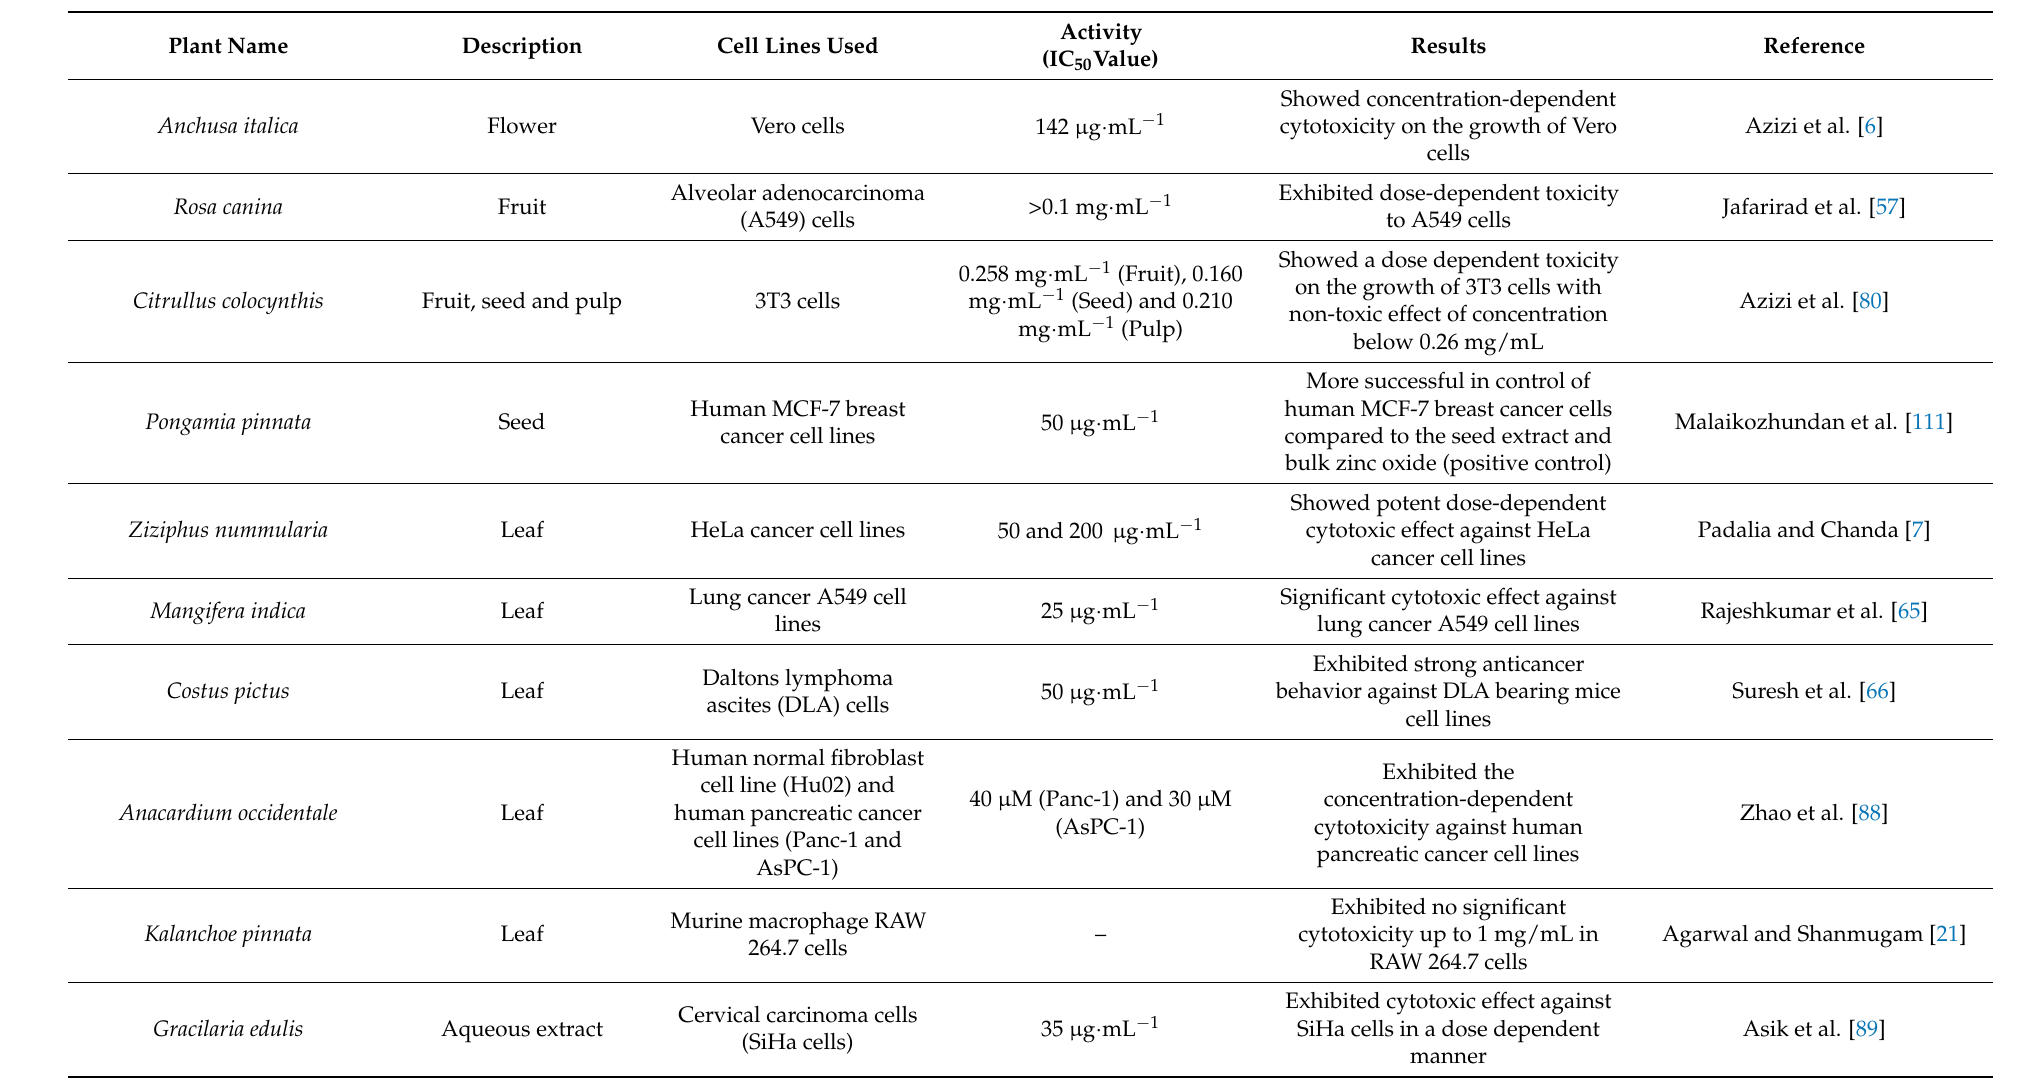
Table 5. Anticancer activity of plant-mediated zinc oxide